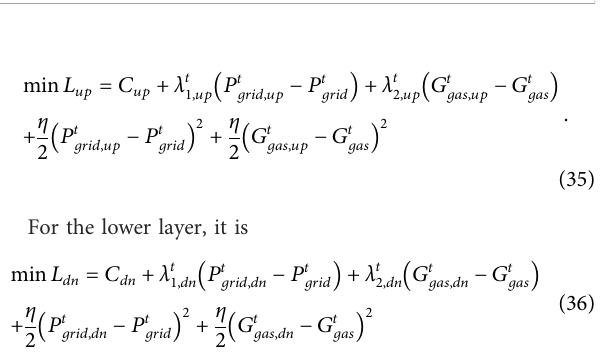
FIGURE 6 Voltage distribution diagram.